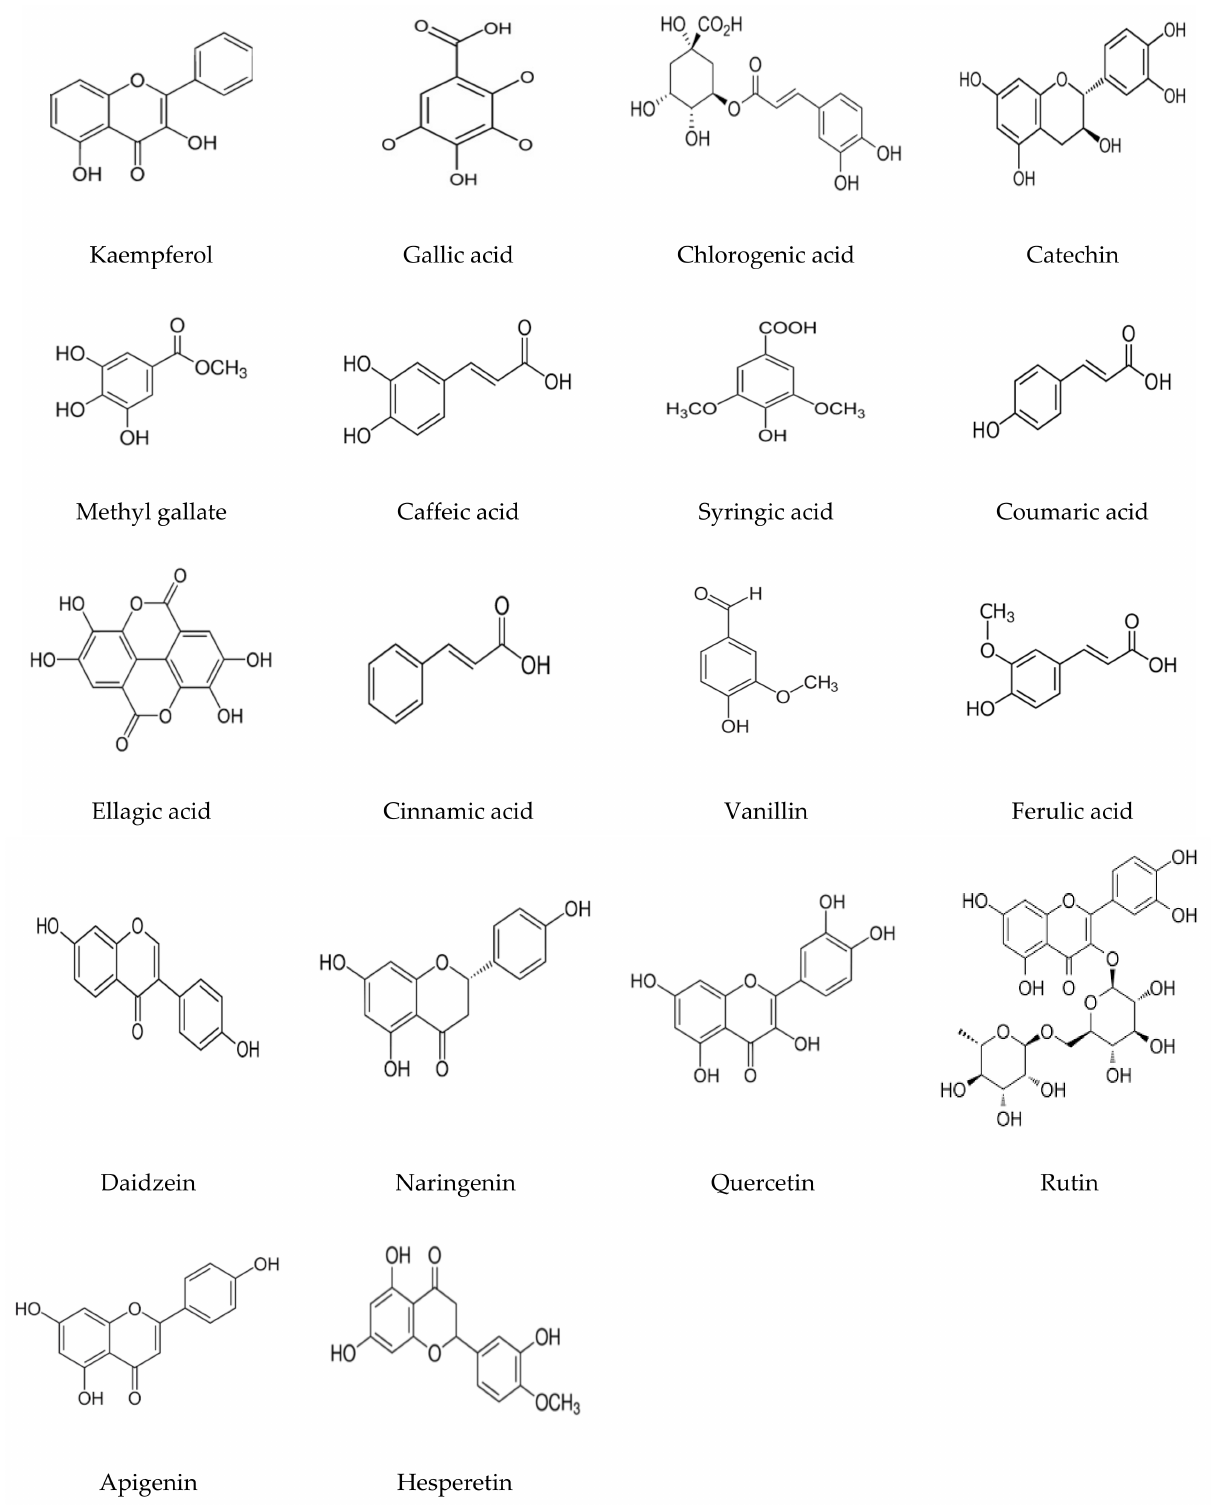
Figure 3. Chemical formulas of compounds detected in Artemisia judaica extract by high-performance liquid chromatography